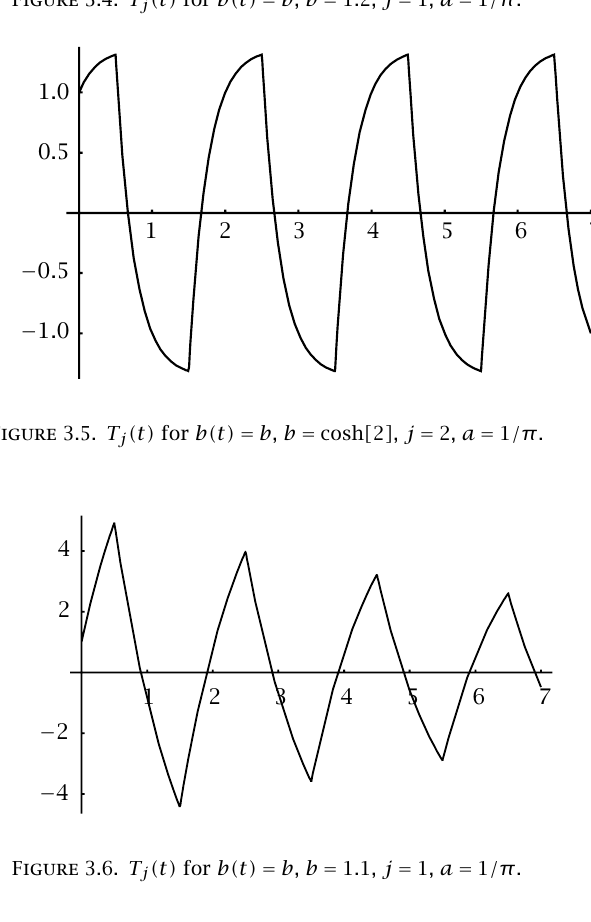
Figure 3.4 . T j (t) for b(t) = b , b = 1 . 2, j = 1, a = 1 /π .